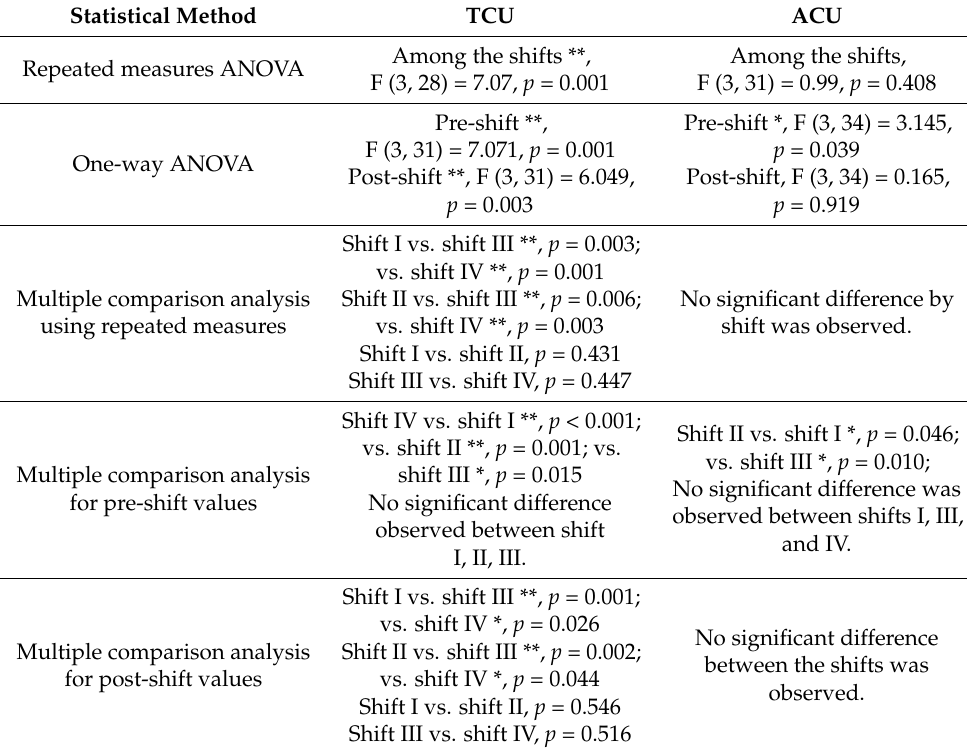
Shift III vs. shift IV, p = 0.516